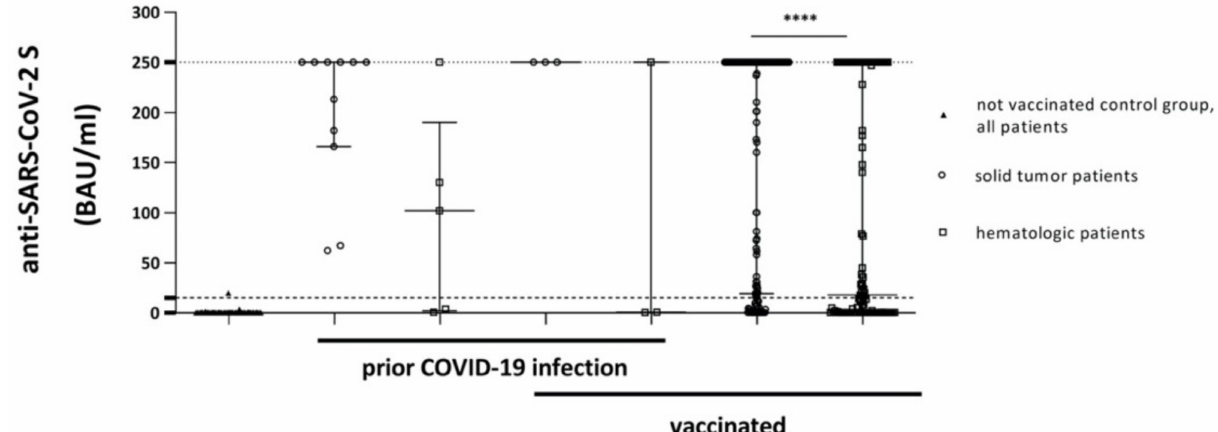
Figure 1. Comparison of antibody levels of included patients: not vaccinated control group, groups with documented prior COVID-19 infections and vaccinated (indexed by thick lines in the description of the x-axis) solid tumor or hematologic patients. Threshold (lower dotted line) indicates ≥ 15 BAU/mL; the upper dotted line shows the upper limit of the assay (250.01). Displayed are median values and 95% CI of BAU/mL values (upper and lower ends of error bars). BAU: Binding Antibody Units. **** p <